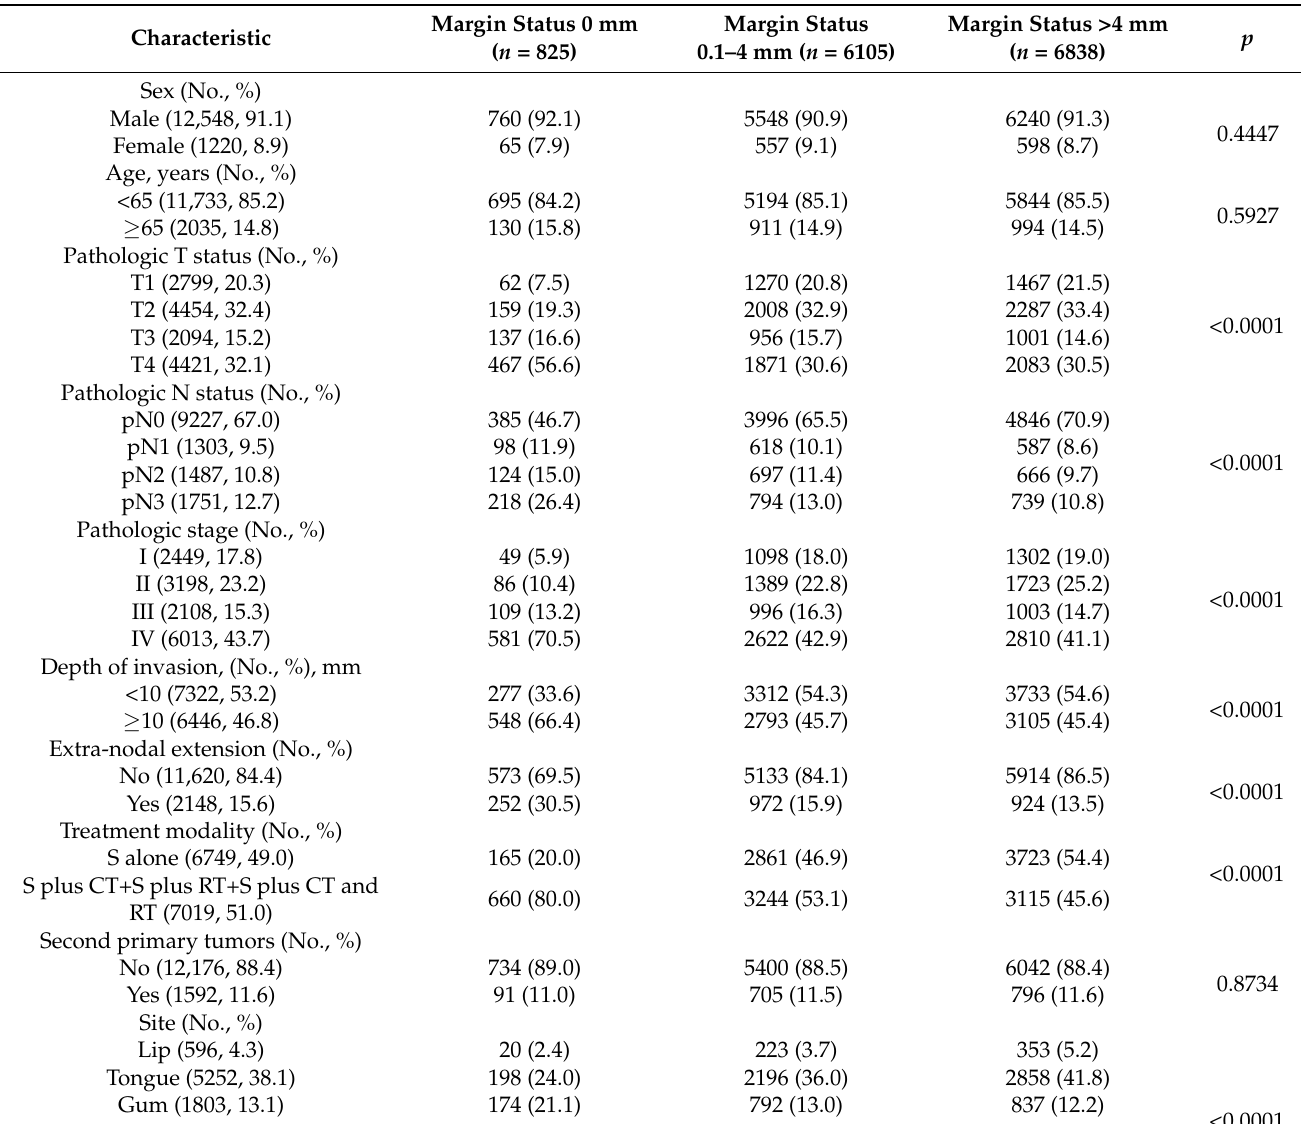
Table 1. General characteristics of patients with oral cavity squamous cell carcinoma stratified according to different margin statuses (0, 0.1–4 and > 4